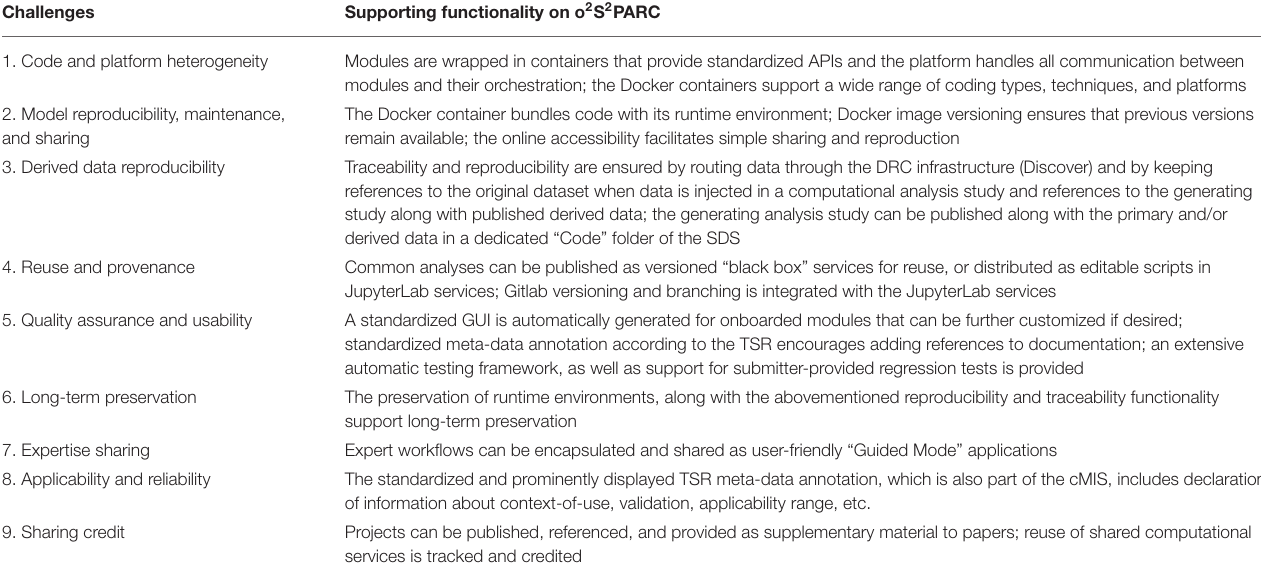
TABLE 1 | Supporting functionality provided by o 2 S 2 PARC to address the challenges raised in section 2.